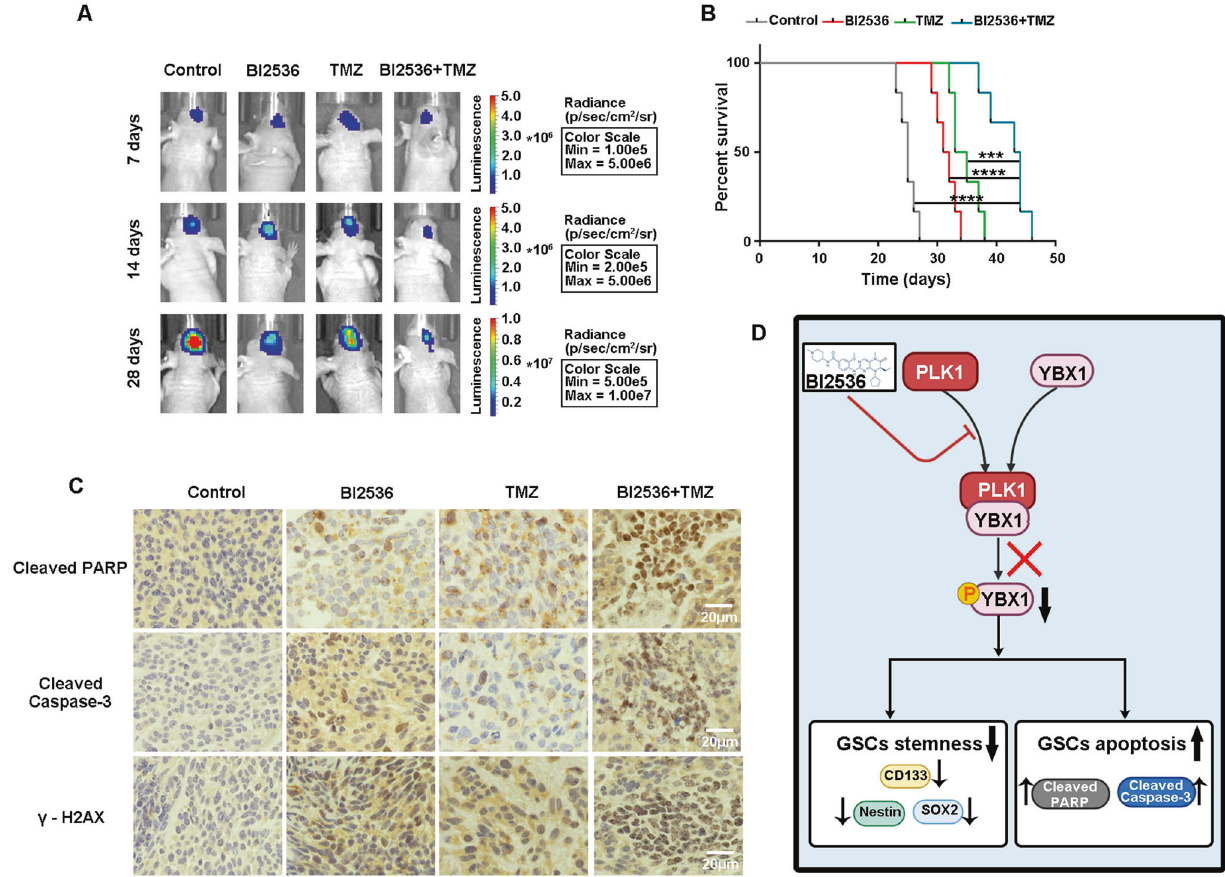
Fig. 8 Combination therapy of PLK1 inhibitor and TMZ preventing tumor growth in the xenograft glioblastoma model. The mice were treated with intraperitoneal injection with DMSO, BI2536 (50 mg/kg/week), TMZ (20 mg/kg/day), or BI2536 (50 mg/kg/week) combined with TMZ (20 mg/kg/day) treatment. The treatment started on the 7th day after implantation and lasted for approximately 28 days. A Representative images of bioluminescence of mice on days 7, 14, and 28 after implantation. B The overall survival of mice in the DMSO, BI2536, TMZ, or BI2536 combined with TMZ treatment groups. Data are shown as the mean ± SD, n = 6, # P = NS, * P < 0.5,** P < 0.1, *** P < 0.001, **** P < 0.0001, compared to the control, ANOVA test. C Representative images of the IHC staining in tumor sections (×100 magni fi cation,